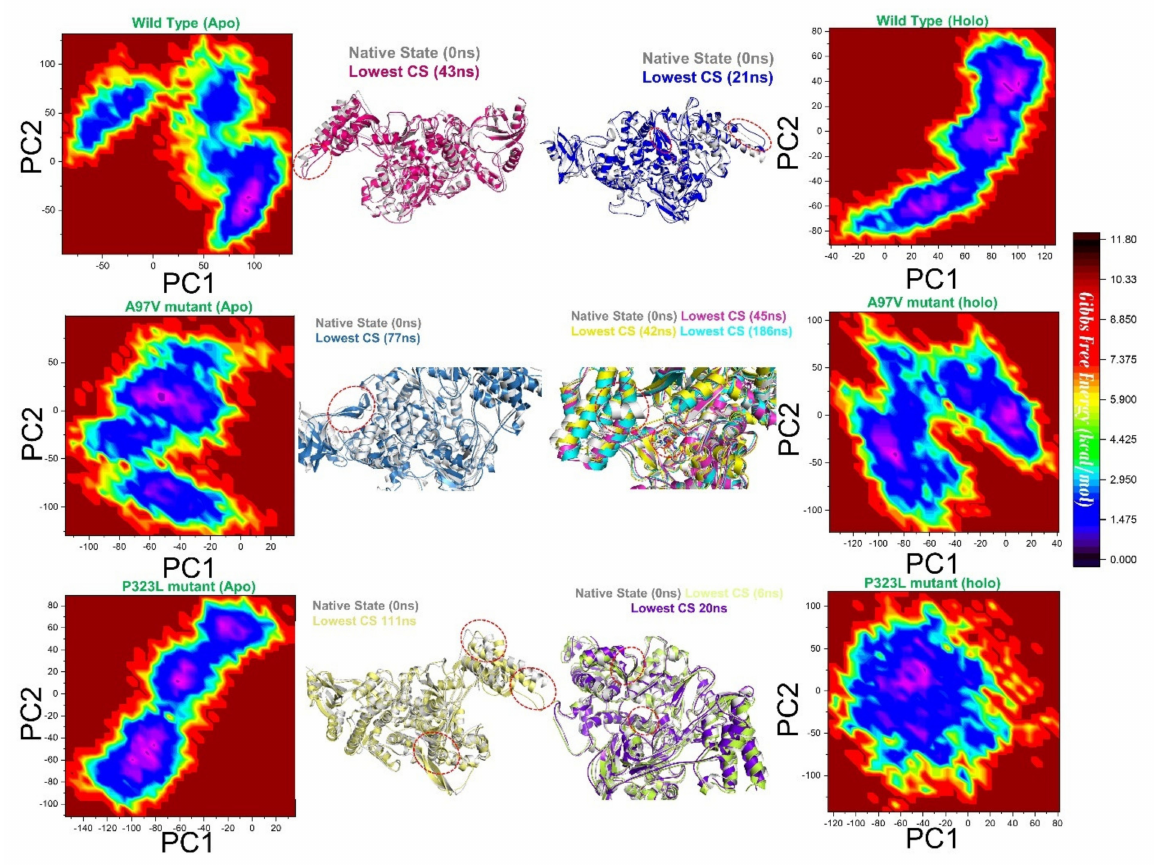
Figure 7. Free energy landscape (FEL) is represented as a function of PC1 and PC2. Projections of motions in the phase space at 300 K of RdRp WT − apo, A97V − apo, P323 L − apo, WT − RdV, A97V − RDV, P323L − RDV are shown. The first and second PC modes from the PCA of the backbone carbon atom fluctuations were